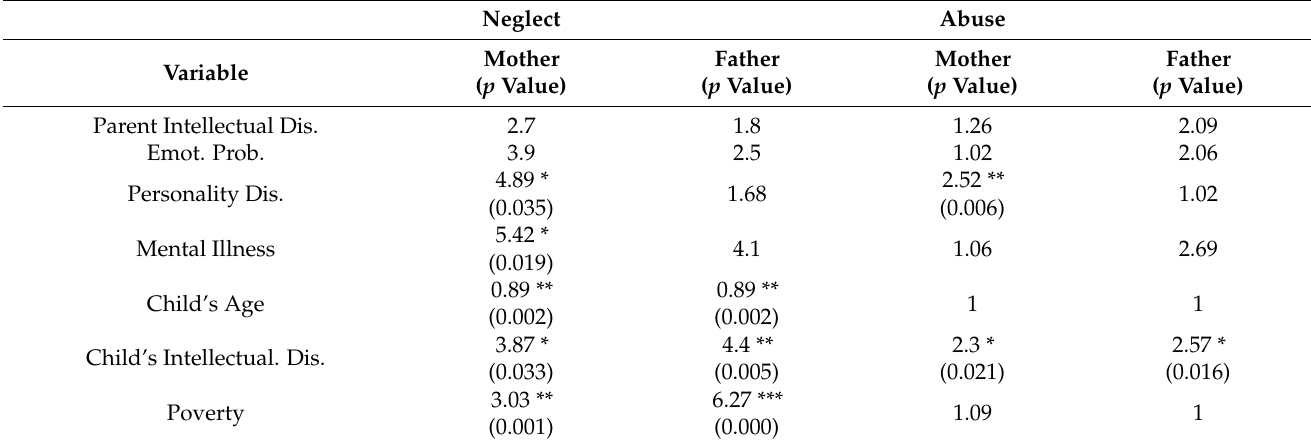
Table 5. Impact of Parental Mental Health on Child